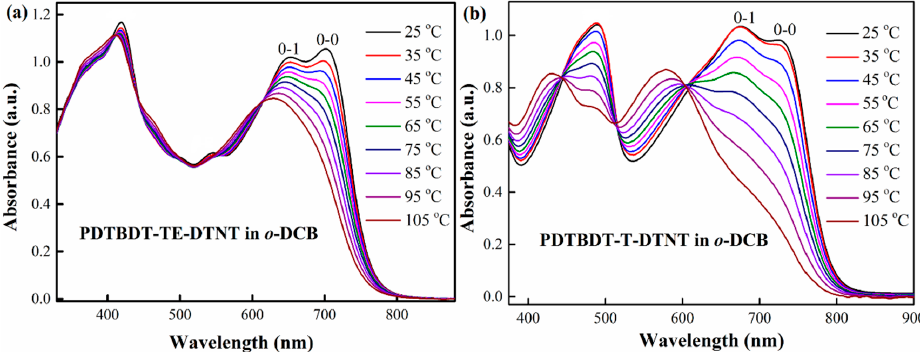
Figure 2. TD-Abs spectra of PDTBDT-TE-DTNT ( a ) and PDTBDT-T-DTNT ( b ) in o- DCB solution.